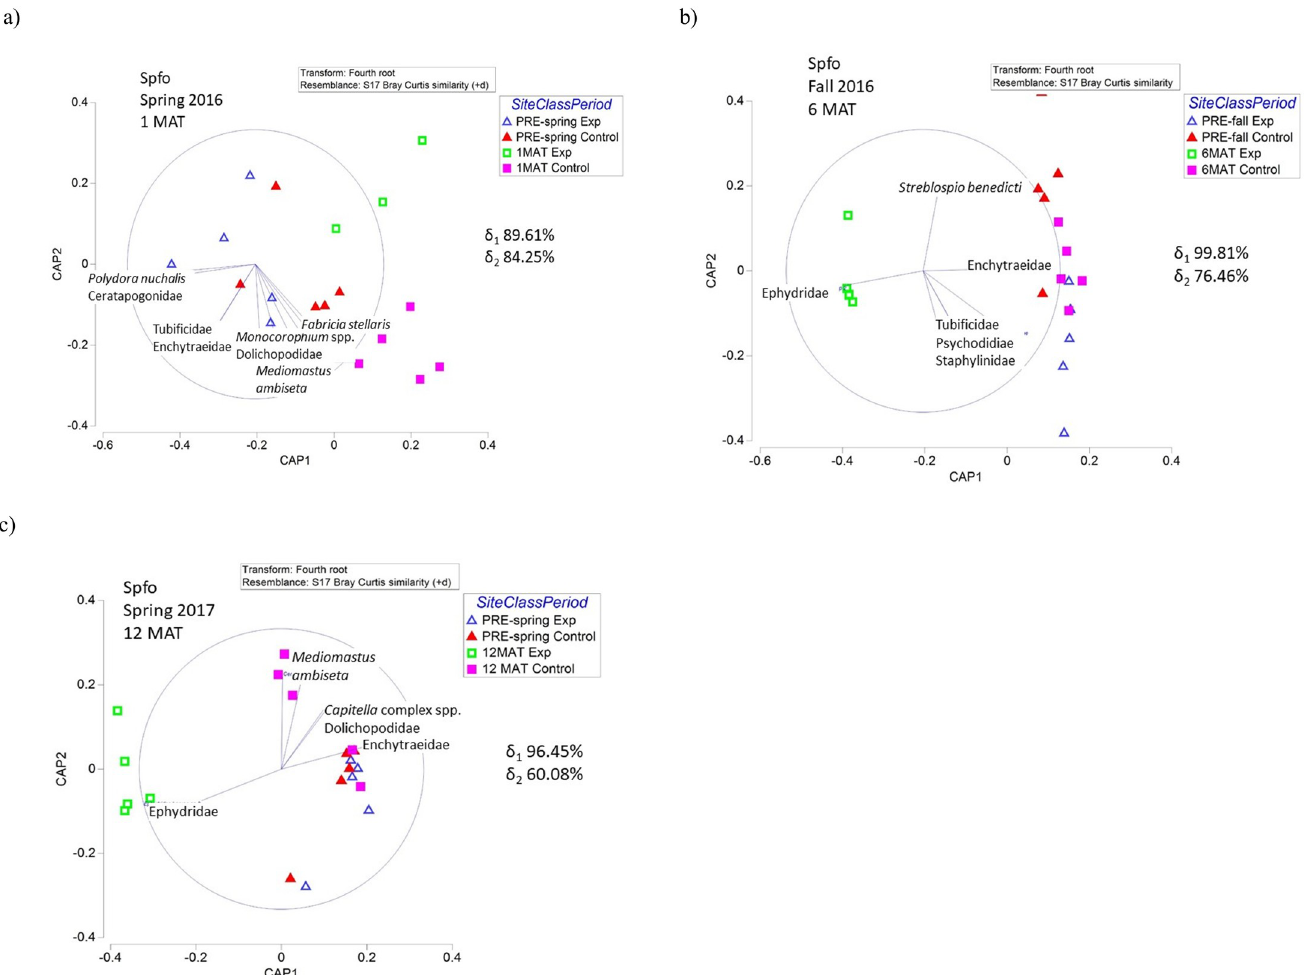
Fig 7. Infaunal invertebrate CAP plots showing the change in community composition of invertebrates for each sampling season (a,b,c) in Spfo habitats compared to pre-sediment application data. Canonical correlation values ( δ ) for each axis are reported to show strength of the association between the multivariate data cloud and the hypothesized group differences. Habitats are abbreviated as follows: Spartina foliosa -dominated (Spfo), Batis maritima- dominated (Bama), and ponds or standing water (Pond). Exp is the experimental sediment application area/site. MAT is months after